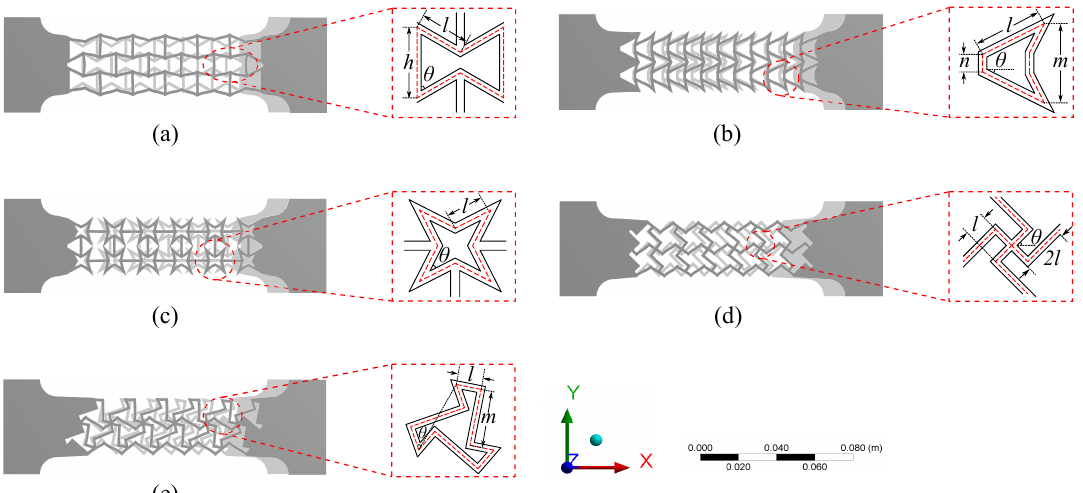
Figure 2. ( a ) Re-entrant hexagonal honeycomb (Pattern A), ( b ) re-entrant triangular-shaped honeycomb (Pattern B), ( c ) re-entrant star system (Pattern C), ( d ) chiral truss (Pattern D), and ( e ) zigzag triangular network (Pattern